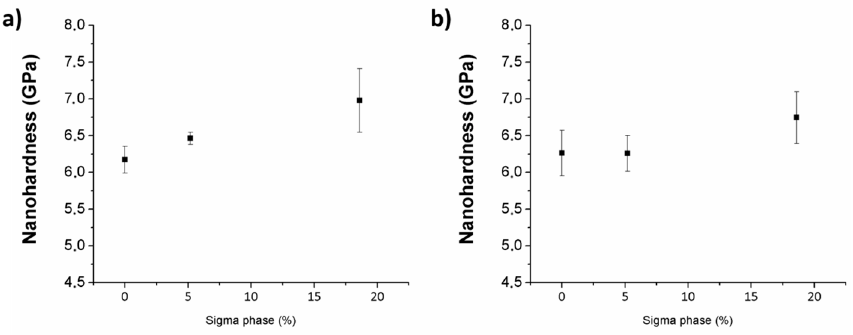
Figure 7. Average nanohardness evolution of ferrite ( a ) and austenite ( b ) vs. sigma phase percentage.